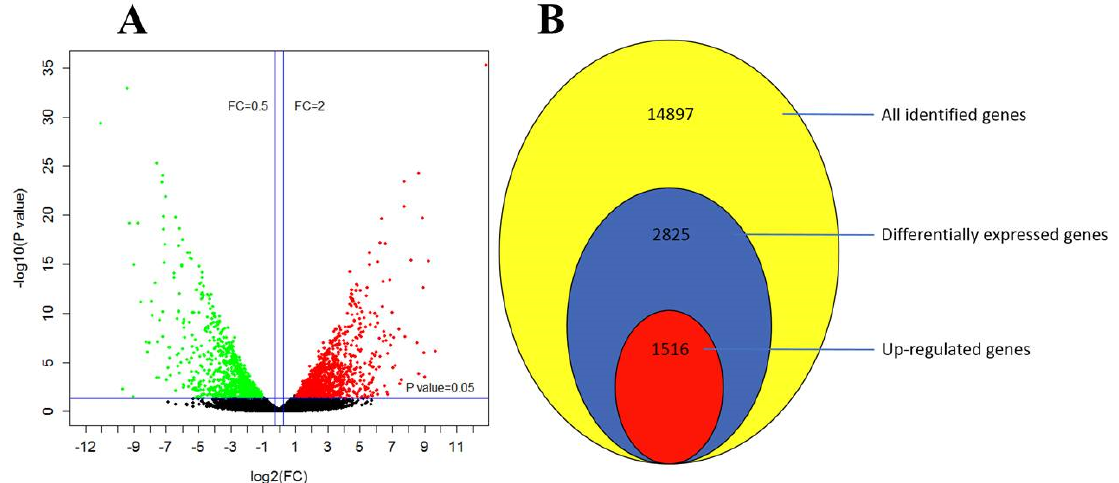
Figure 4. Cuminal exposure regulated gene expression of T. roseum at mRNA level. ( A ) The volcano plot of detected genes indicating significantly up (red) and down (green) regulated genes. ( B ) Comparison of the numbers of all identified genes and di ff erentially expressed genes (up vs. down regulated).